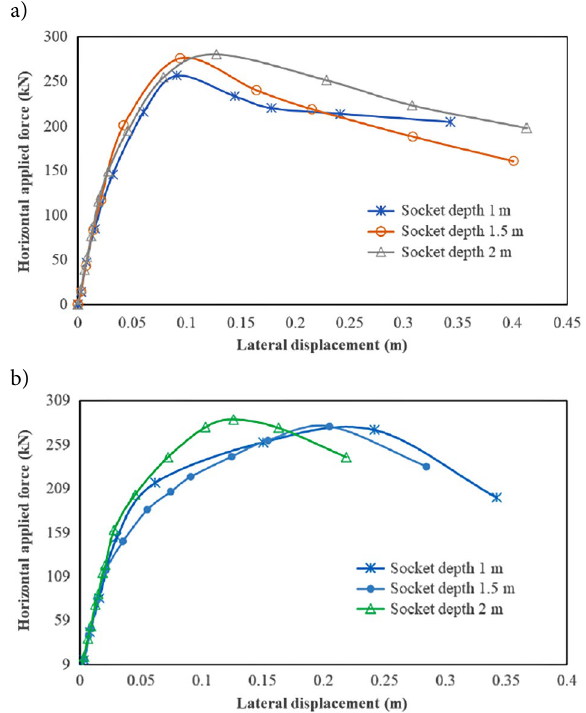
Figure 14. Lateral displacement versus applied horizontal applied force at top of column for 12m-height